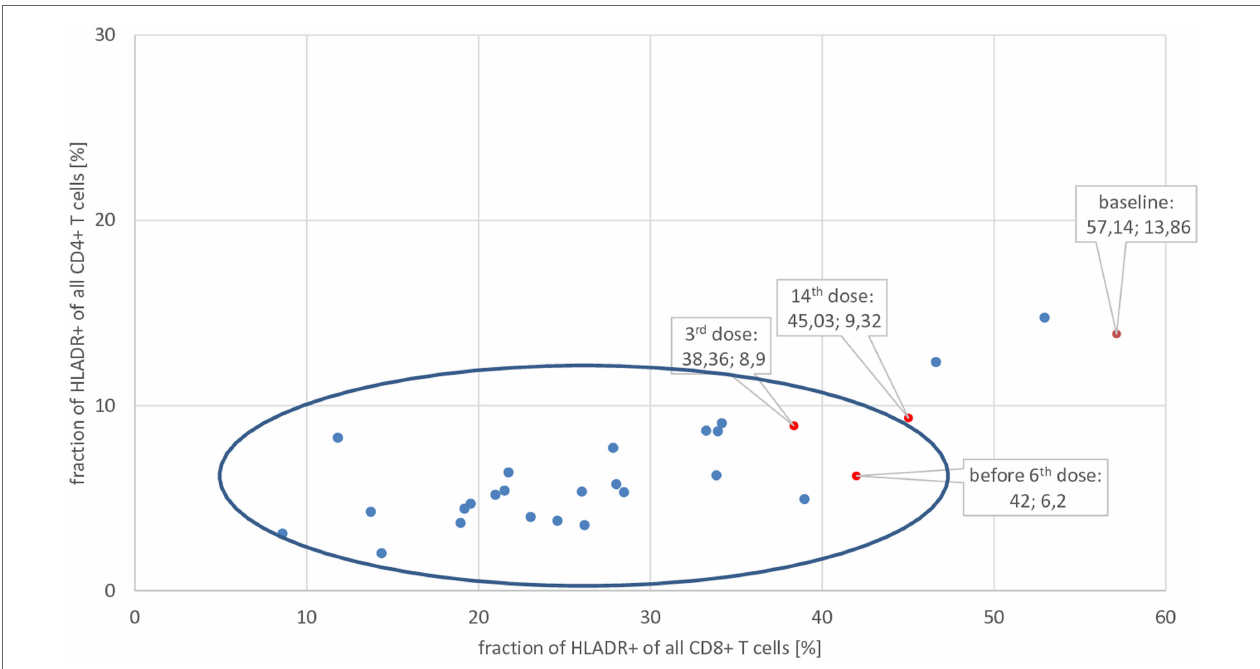
ellipse represents mean plus/minus 2 SDs of the fraction of activated CD8 + T-lymphocytes; the minor axis of the ellipse represents mean plus/ minus 2 SDs of the fraction of activated CD4 + T-lymphocytes of normal controls. Thus, dots outside of this ellipse significantly differ from normal